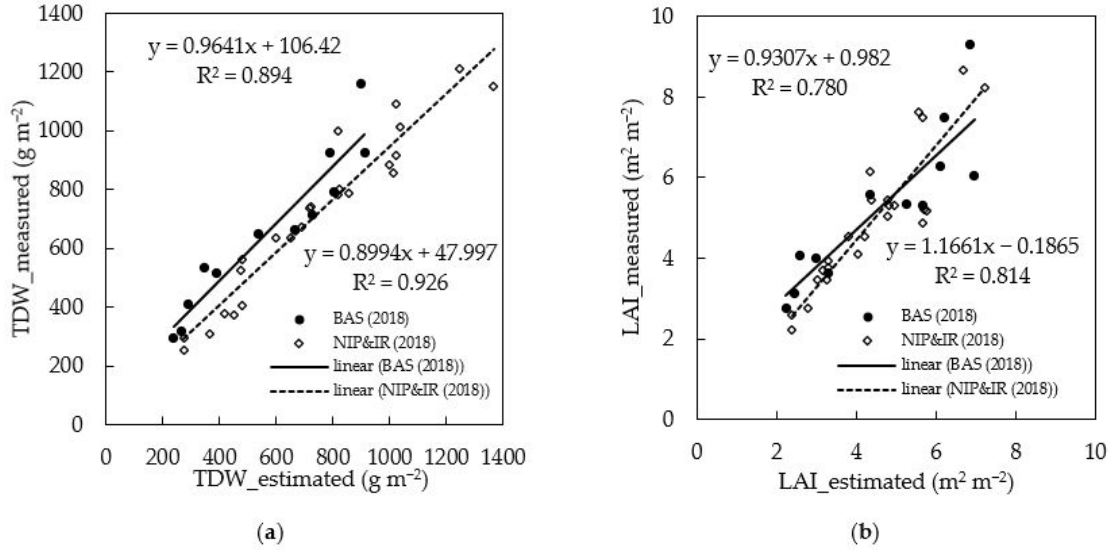
Figure 10. Accuracy assessment of CSM derived estimated ( a ) LAI and ( b ) TDW against standard ground-based measure- ments in 2018 (Rep. 2). BAS: n = 12, NIP and IR: n = 24.